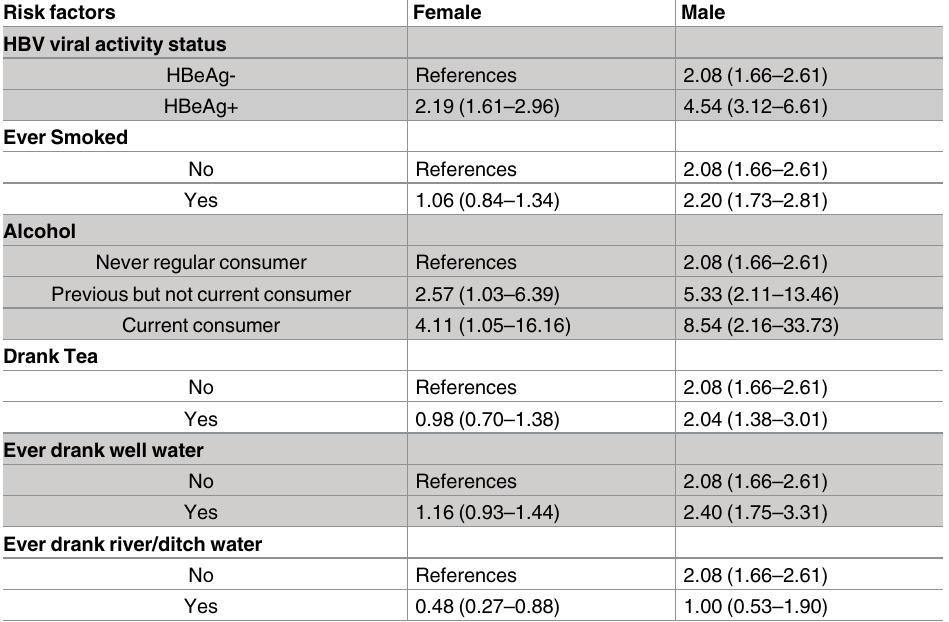
Table 4. Odds ratios for liver disease severityin risk factors by